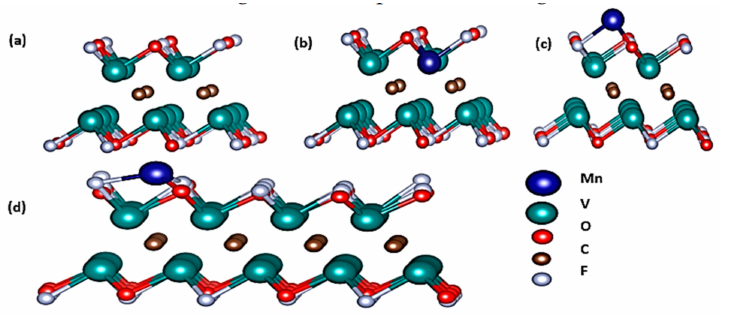
Figure 3. ( a ) Structure of pristine V 2 C, ( b ) structure of Mn-doped V 2 C, ( c ) structure of Mn-adsorbed V 2 C in 2 × 2 × 1 supercell, ( d ) structure of Mn-adsorbed V 2 C in 4 × 4 × 1